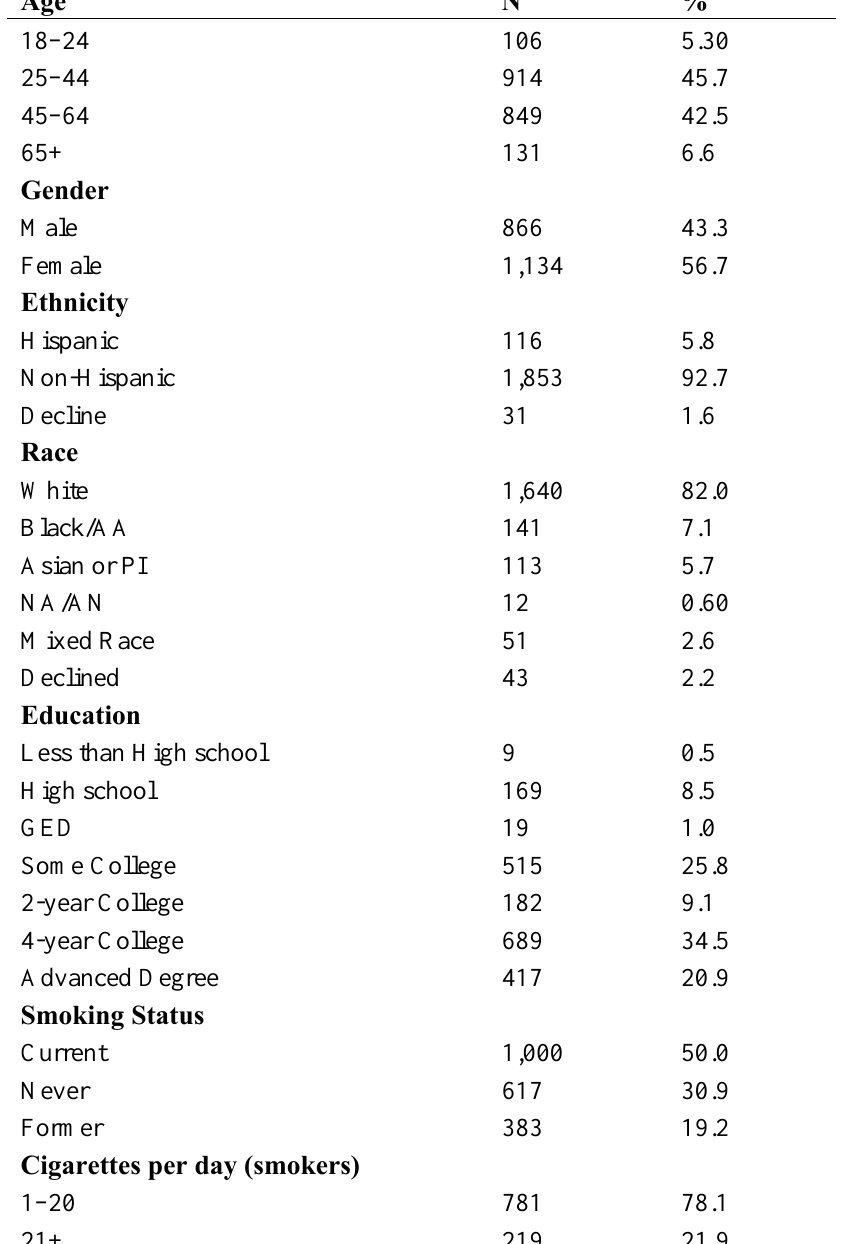
Table 1. Sociodemographic and smoking characteristics (n =